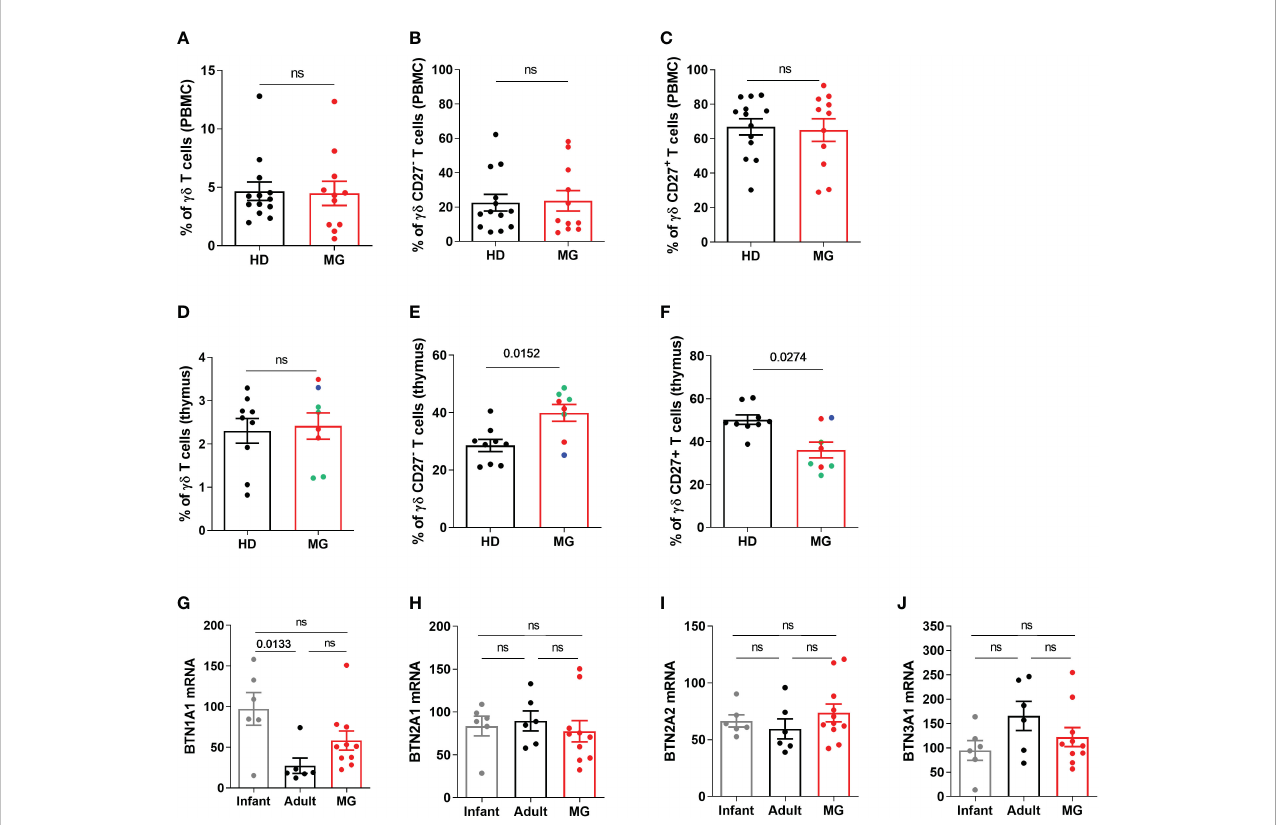
FIGURE 5 Peripheral and thymic gd T cells in controls and MG patients. Analysis by fl ow cytometry of the percentages of gd T cells (A, D) , of CD27 - (B, E) and CD27 + (C, F) gd T cells in PBMCs and thymic cells, respectively, from healthy individuals (HD) or in AChR MG patients (MG). The degree of thymic follicular hyperplasia was indicated: numerous (red dots), few (green dots), and none (bleu dot) germinal centers. RT-PCR analysis for BTN1A1 (G) , BTN2A1 (H) , BTN2A2 (I) , and BTN3A1 (J) in the thymus of healthy individuals (infants or adults) and AChR MG patients). p values were determined by the Mann-Whitney test (A – F) or the Kruskal-Wallis test with Dunn ’ s multiple comparisons test for multiple comparisons (G – J)